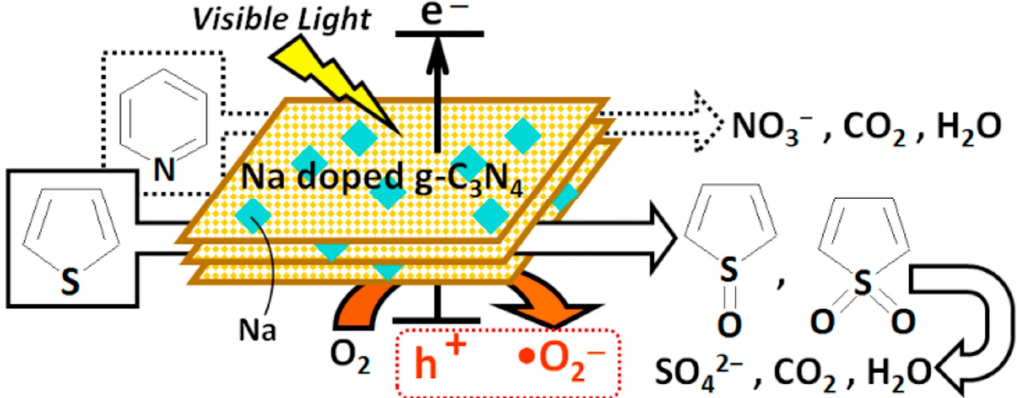
Figure 5. Mechanism of the photocatalytic denitrogenation and desulfurization over the Na/g-C 3 N 4